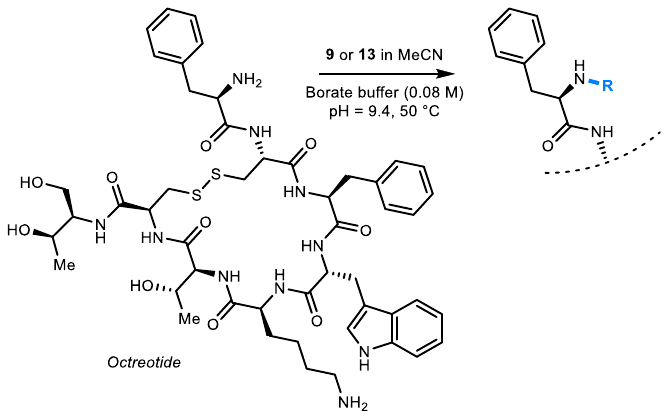
Figure 5. Bioconjugation of 9 and 13 with octreotide (hypothetical selective N-terminal functionalization shown for clarity).